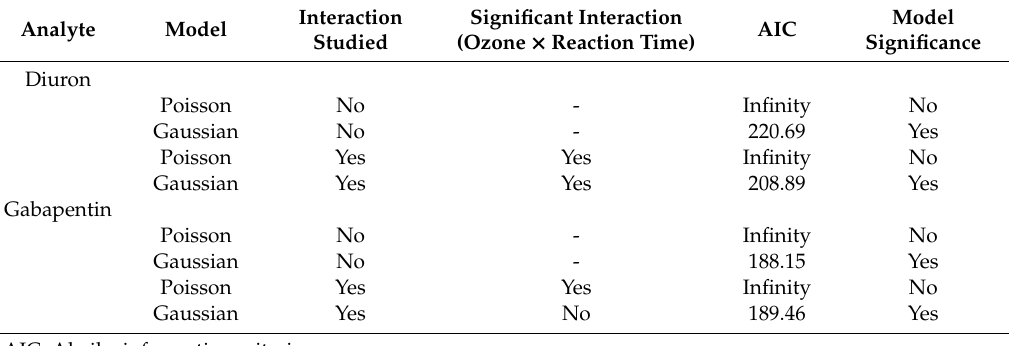
Table 6. Poisson and Gaussian model in GLM regression analysis for degradation results after ozonation